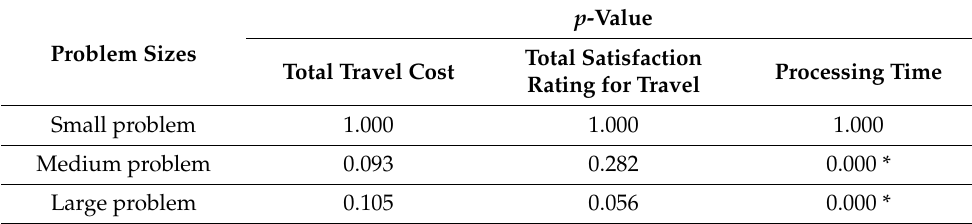
Note that * indicates a significant difference.